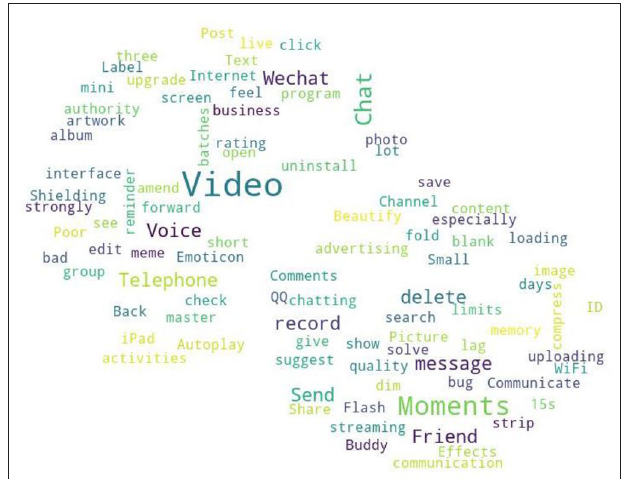
FIGURE 3 | Functional insufficiency in WeChat.